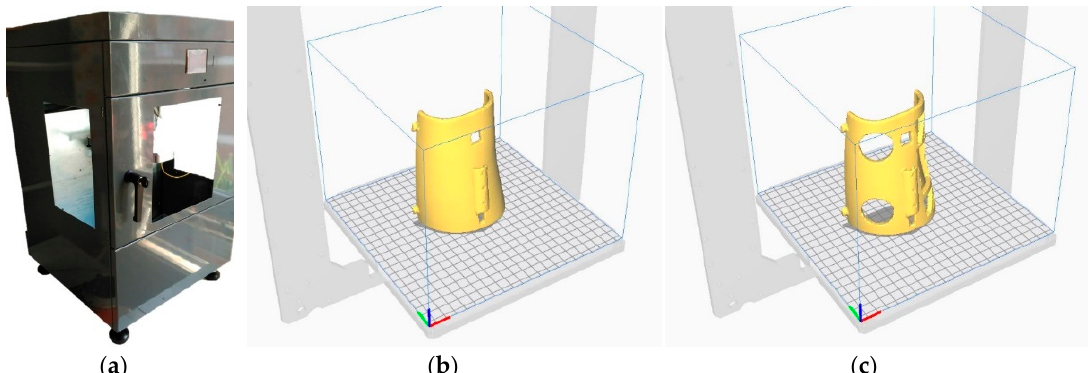
Figure 7. TotalPrinter machine developed to work with biomaterials ( a ). G-Code process generation for 3D printing for the different parts of the splint ( b) and ( c ).